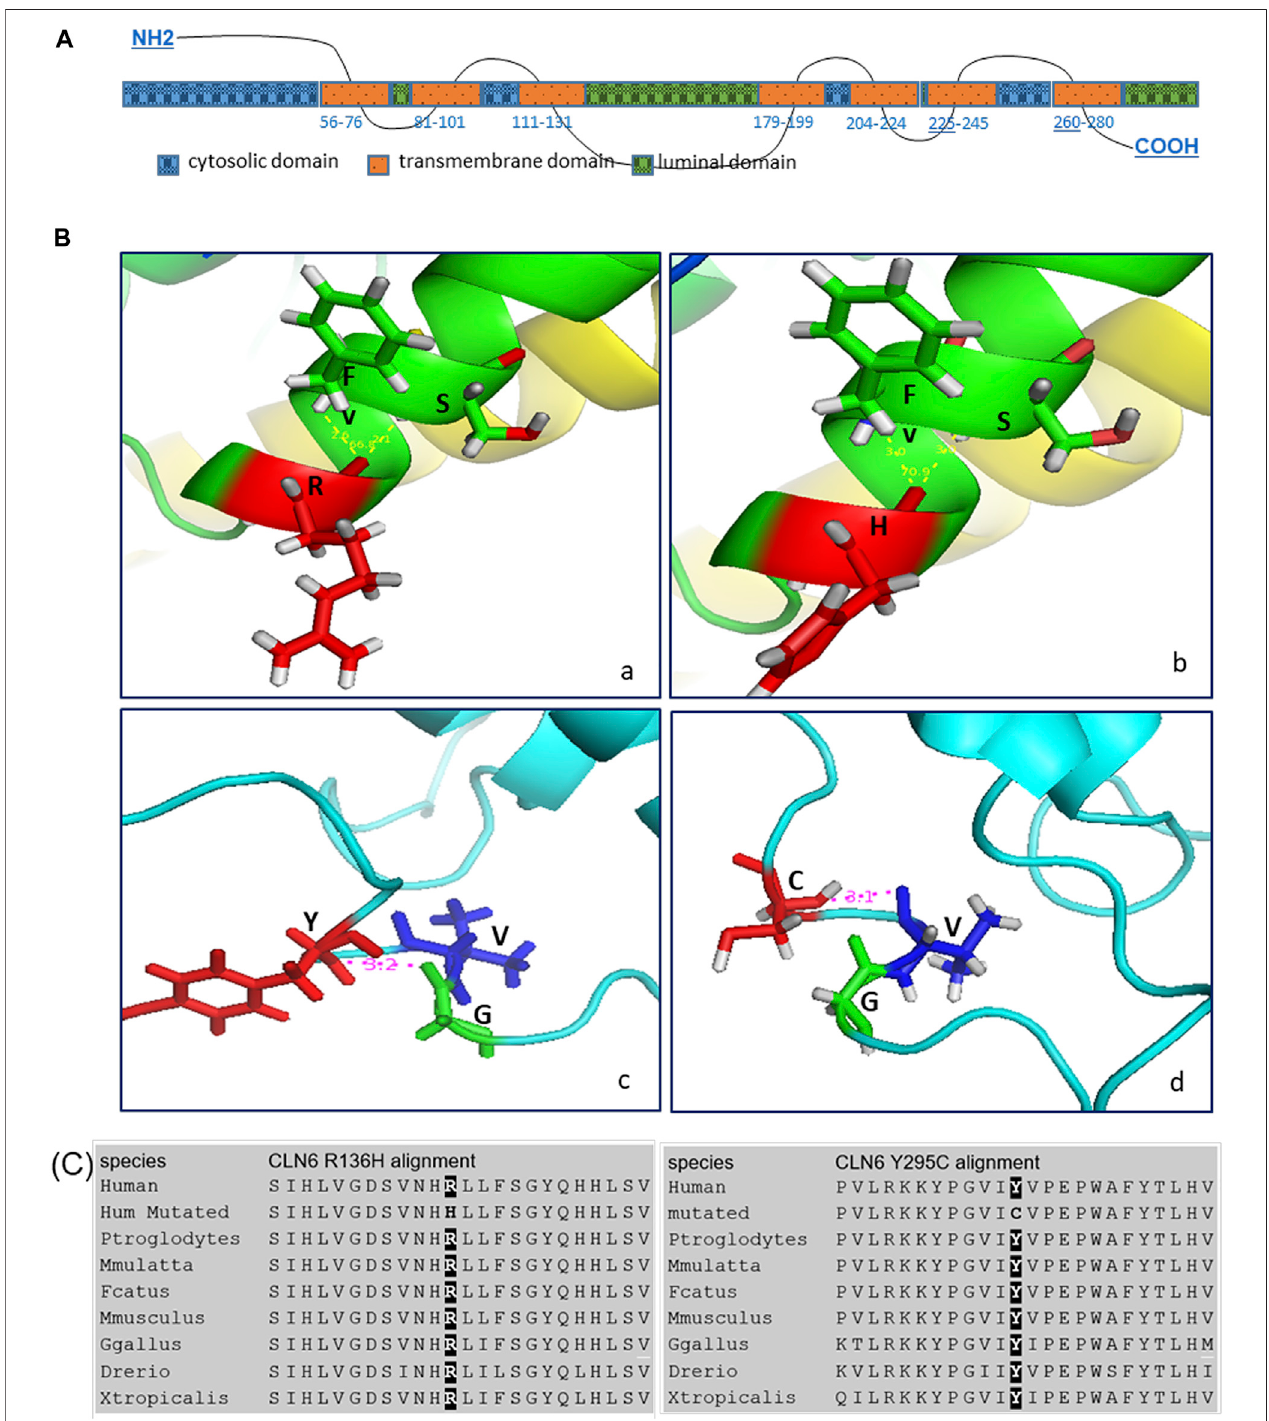
FIGURE 3 | (A) CLN6 protein predicted domains. (B) In silico structural analysis showed the predicted CLN6 protein 3D structure, based on Protein Data Bank (PDB)ID: 2yevA , 3wajA , 5amrA , 3ayfA , 5i6xA ,and 3rkoB ofthewild-typearginine(a)/mutanthistidine(b)atposition136(showninredcolor)andofthewild-typetyrosine (c)/mutantcysteine(d)atposition295(showninredcolor).Theinteractingmoleculesareshowningreenandbluecolors,andthestructuresareshowninthesamescale and orientation. The corresponding numbers between the bonds are in angstrom (Å) units, and the angles are in degree ( ° ). (C) Alignment analysis showed the arginine/histidine at position 136 and the tyrosine/cysteine at position 295 conservation among different species.